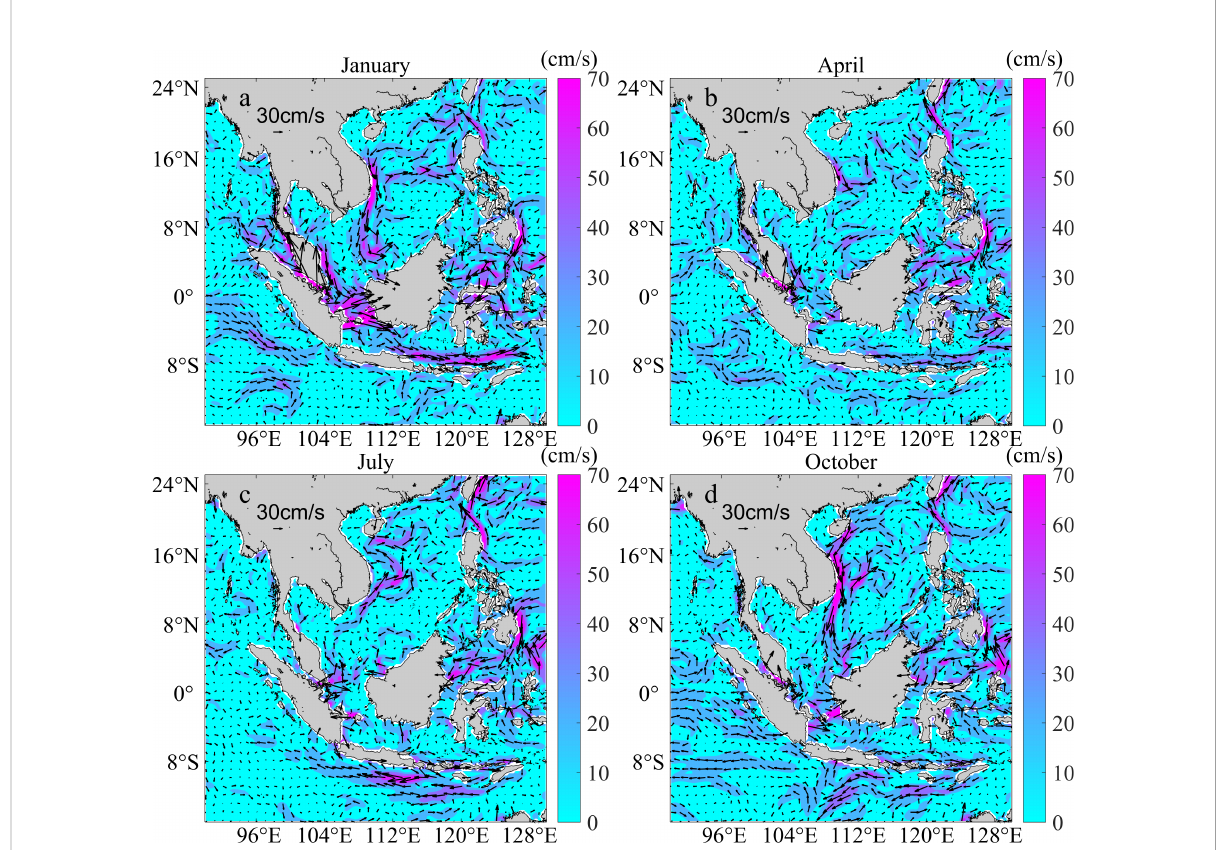
FIGURE 1 Ocean currents in January, April, July, and October, 2019 in the Indo-Paci fi c convergence region. Arrows show the circulation direction, and the arrow length and color scale bar indicate the fl ow